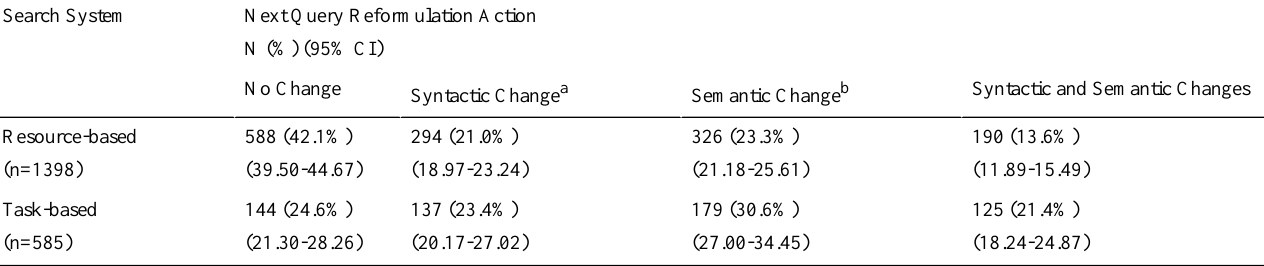
Table 4. Comparison of next query reformulation actions between resource-based and task-based system